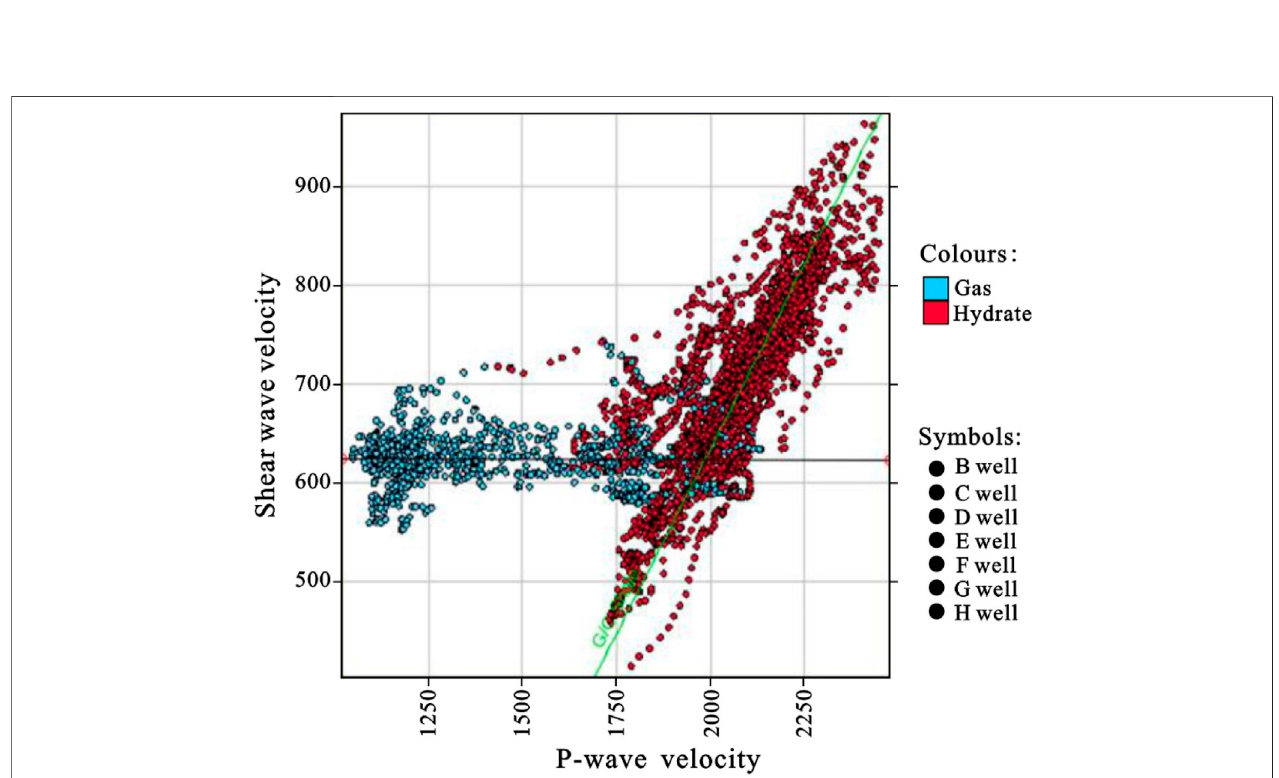
FIGURE 12 | Relationship of longitudinal and S-wave velocity between hydrate layer and free gas layer.